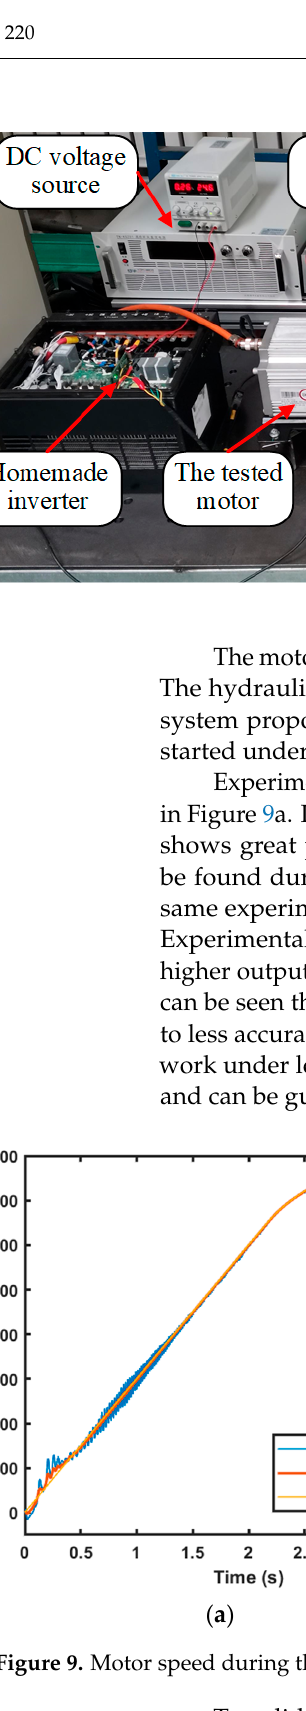
Figure 9. Motor speed during the startup process: ( a ) Non-loaded situations; ( b ) Loaded situations.